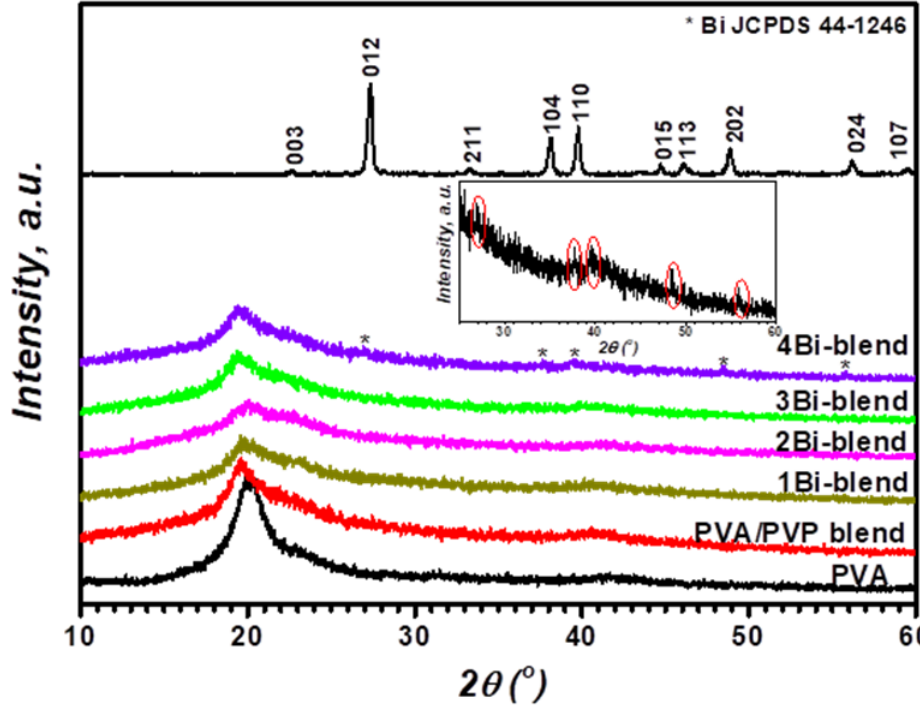
Figure 1. XRD patterns of pristine PVA, PVP/PVA blend, Bi-metal powder, and Bi-blend hybrid